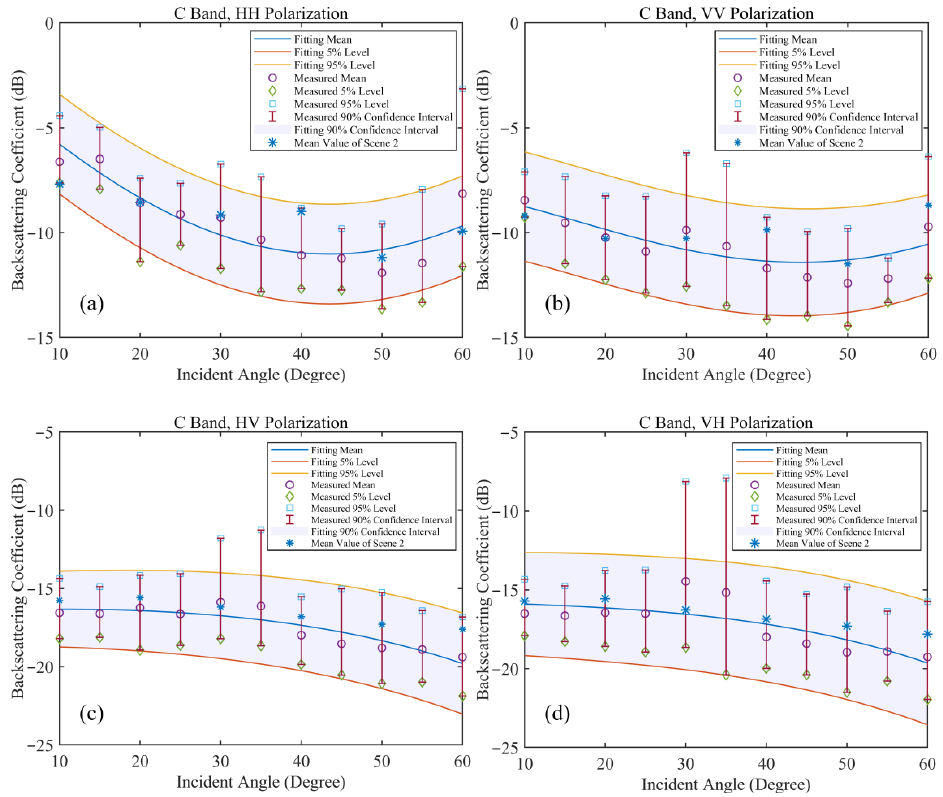
Figure 18. Angular variations of the mean backscattering coefficient of rice field Scene 1 as a function of the incidence angle at the C band for ( a ) HH, ( b ) VV, ( c ) HV, and ( d ) VH